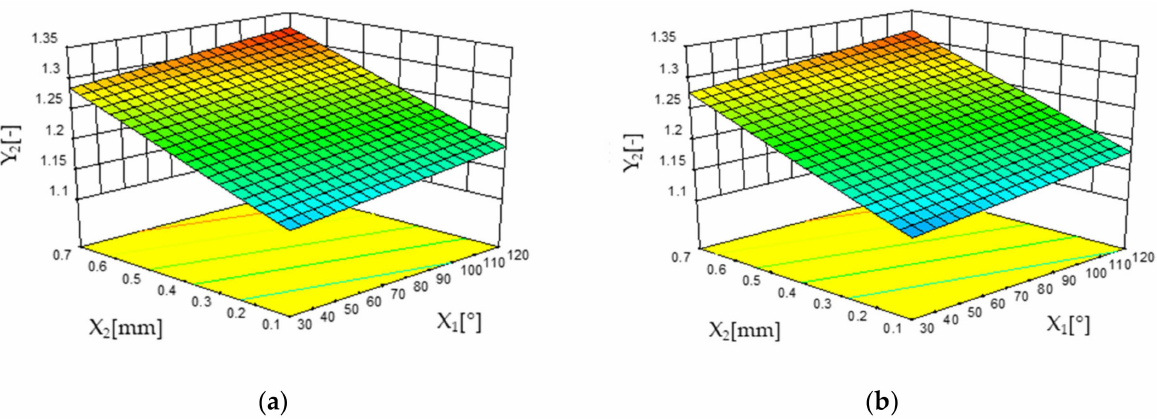
Figure 4. The 3D plots showing interaction effects of the drill tip angle (X 1 ) and tooth bite (X 2 ) on the delamination factor at the inlet (Y 2 ) when the holes were ‘performed’ with a flat drill ( a ) and with a helical drill ( b